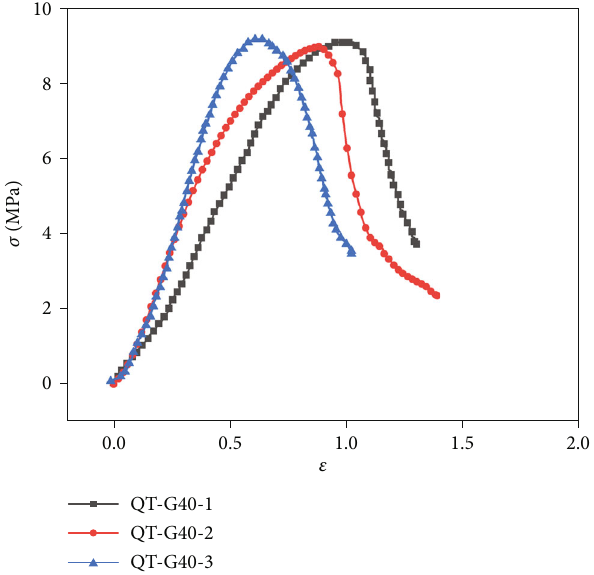
Figure 7: Stress-strain curve of uniaxial